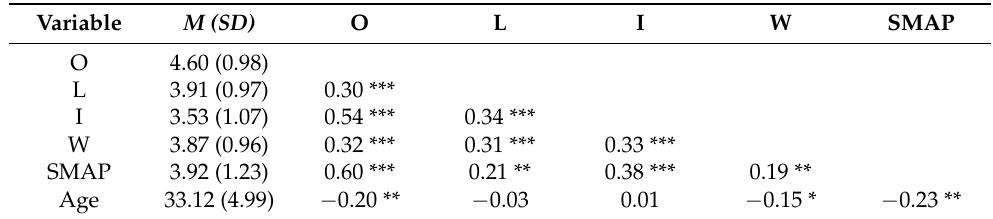
Table 4. Means, standard deviations and intercorrelations between mothers’ self-reported playfulness and their